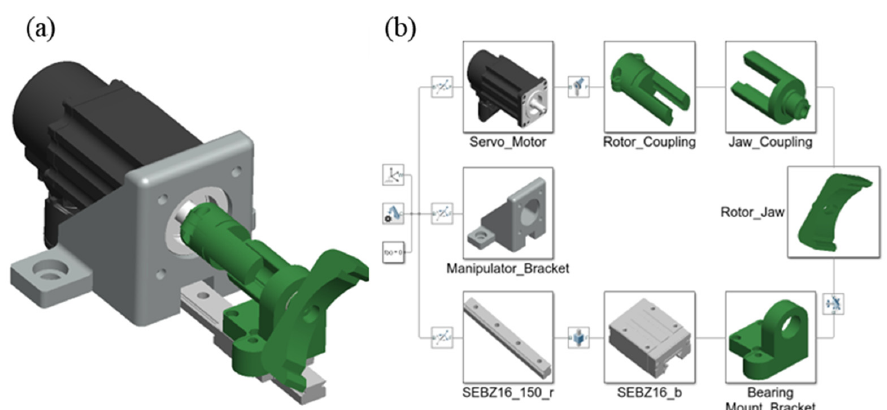
Figure 6. ( a ) CAD model of System in Solidworks ® : ( b ) Simscape TM Multibody Block diagram in Simulink ® .